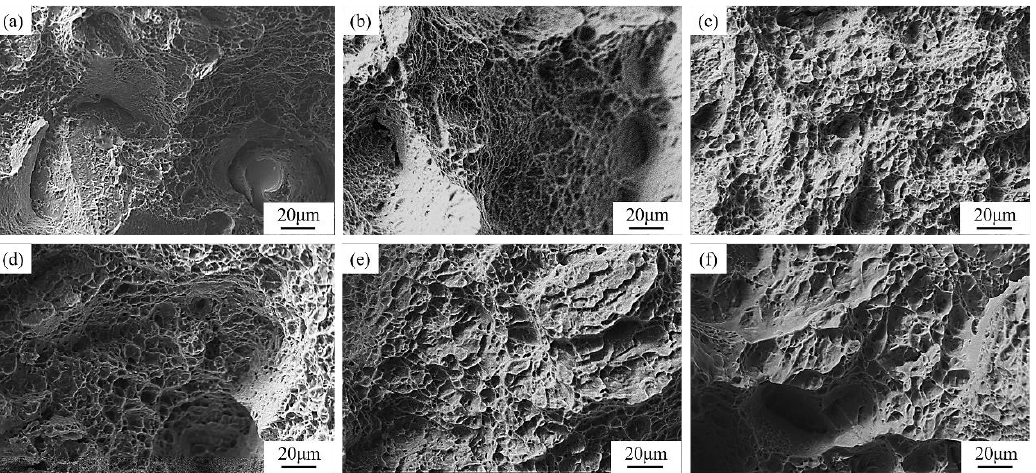
Figure 8. Tensile fracture surface of the as-built and heat-treated samples. ( a ) as-built; ( b ) 630 °C ; ( c ) 800 °C ; ( d ) 850 °C ; ( e ) 900 °C ; ( f ) 950 °C .